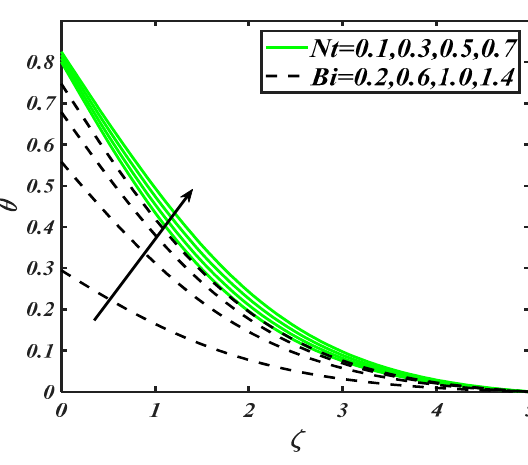
Figure 6. Illustration of Nt and Bi on θ